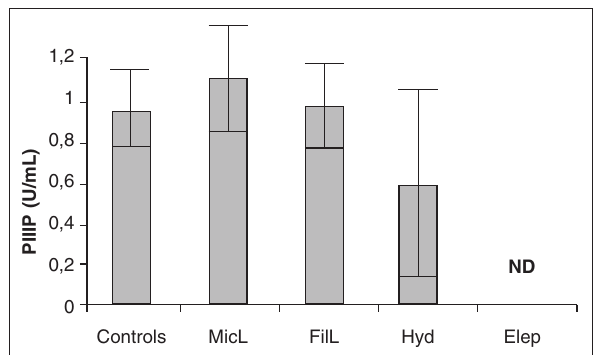
Fig. 2. – Serum levels of N-terminal propeptide of type III collagen, determined by RIA, in patients with lymphatic filariasis according to their clinical status. FilL: filarial lymphangitis; ChyL: chyluria; Hyd: hydrocoele; EleP: ele- phantiasis, in comparison with controls and bacterial lymphangitis